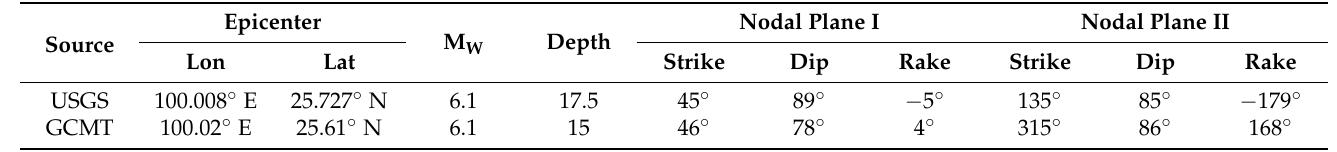
Table 1. Focal mechanism solutions of the Yangbi M W 6.1 earthquake provided by different